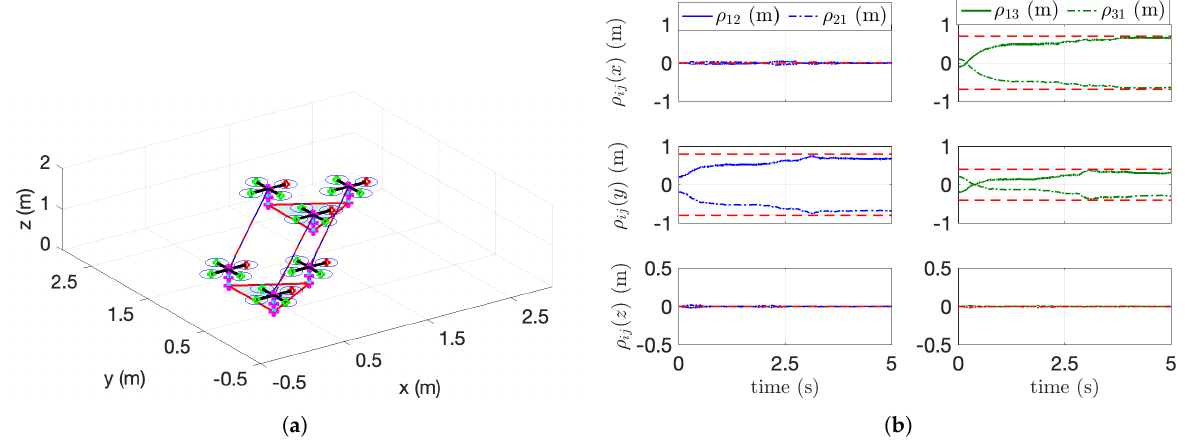
Figure 8. Trajectory tracking of three cooperative aerial manipulators. ( a ) 3D fight of three aerial manipulators. ( b ) Estima- tion of relative distances ( ρ ij ).